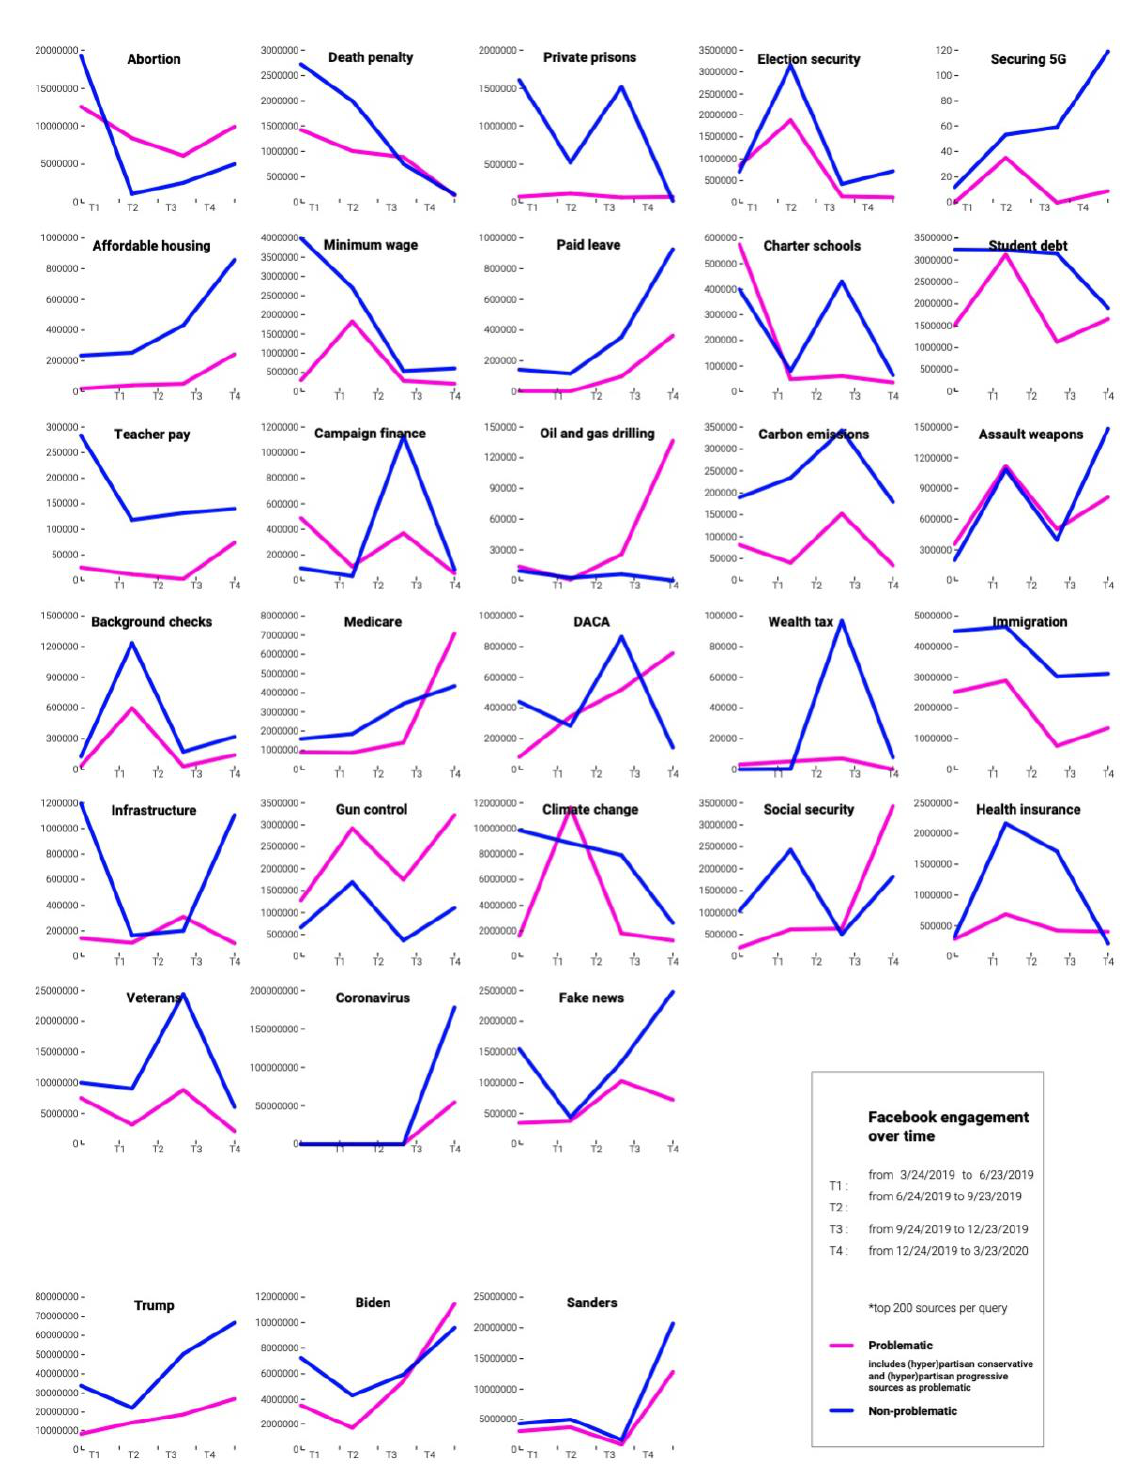
Figure 6. Facebook engagement scores of ‘fake news’ (Silverman’s original roomy definition) versus mai nstream news for political candidate and social issue queries, March 2019 - March 2020. Absolute numbers shown for the sake of trend comparison. Source: